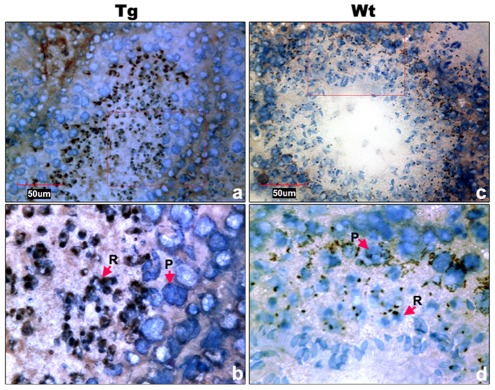
Cell types of Miwi-EGFP expression in transgenic mouse testis.a), Immunocytochemical localization of EGFP in transgenic mouse testis using anti-EGFP antibody. c), Endogenous Miwi expression was detected in the wild-type testis using anti-Miwi antibody. Signals were detected with horseradish peroxidase-conjugated secondary antibody (brown). Bottom panels (b,d) are enlarged images (100×) from the squares in their respective upper panels (a,c) (40×). Negative controls were showed in Figure S1B. Nuclei were re-dyed with hematoxylin (blue). P, pachytene spermatocytes; R, round spermatids.